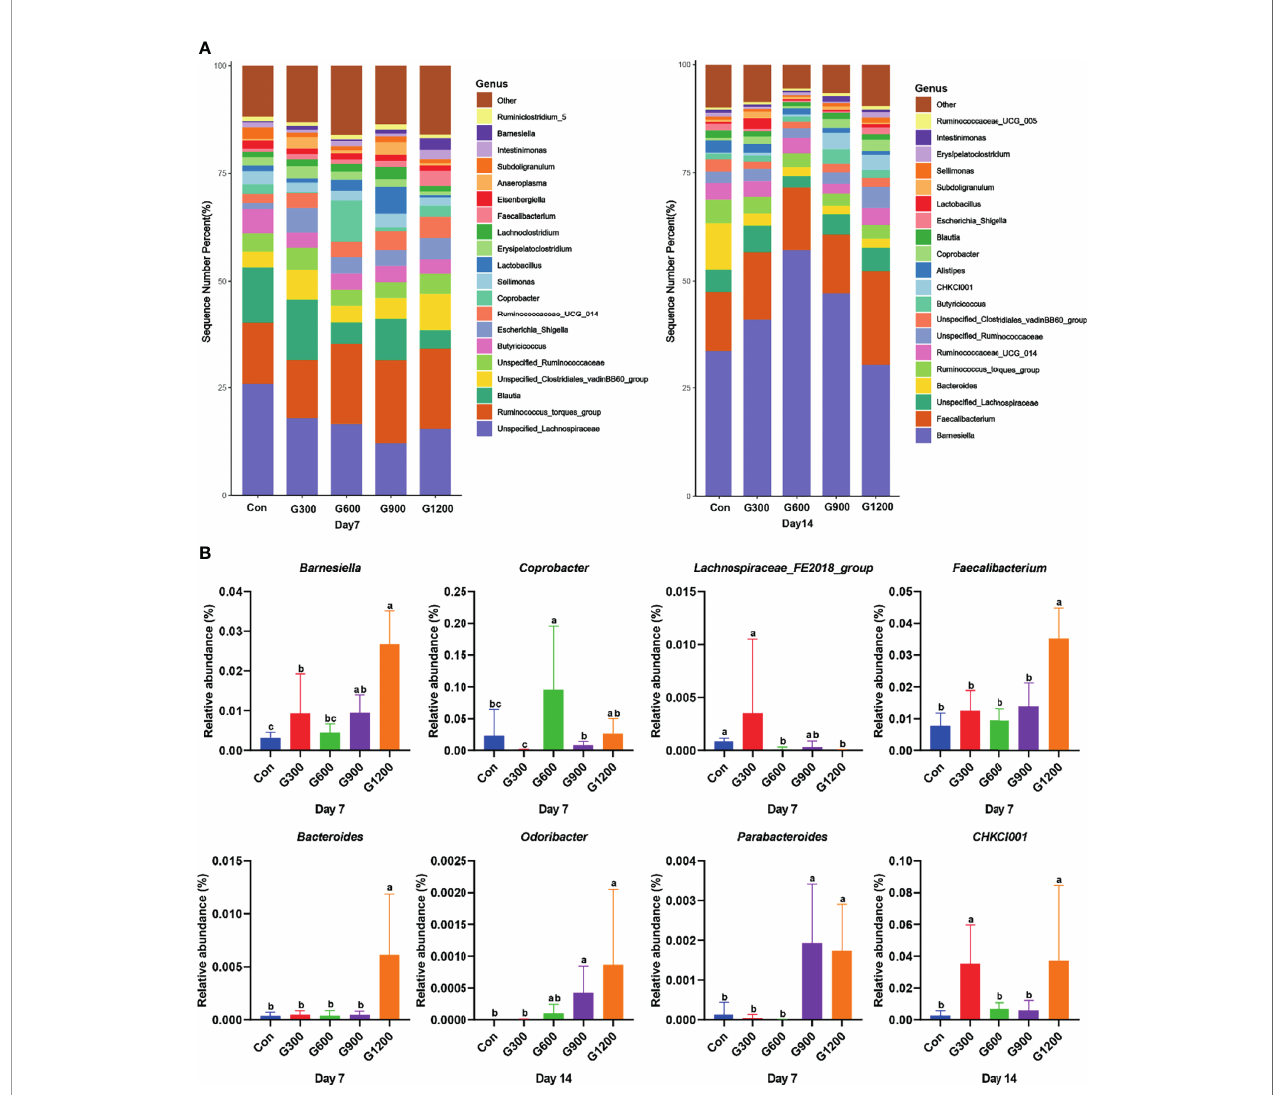
FIGURE 3 | Alteration of cecal microbiota on the genus level. (A) Relative abundance of top 20 bacterial genera presents in each group. (B) The relative abundance differs signi fi cantly among groups at the genus level. Different superscripts indicate signi fi cant differences according to the Kruskal-Wallis test ( P < 0.05). Con, basal diet; G300, 600, 900, and 1200, basal diets complemented with 300, 600, 900, or 1200 mg/kg